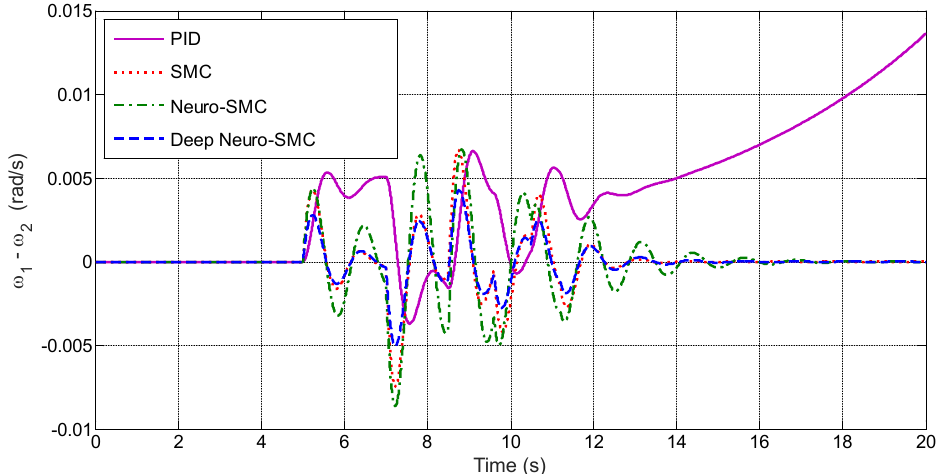
Figure 8. Comparison of generator speed changes (Third case).